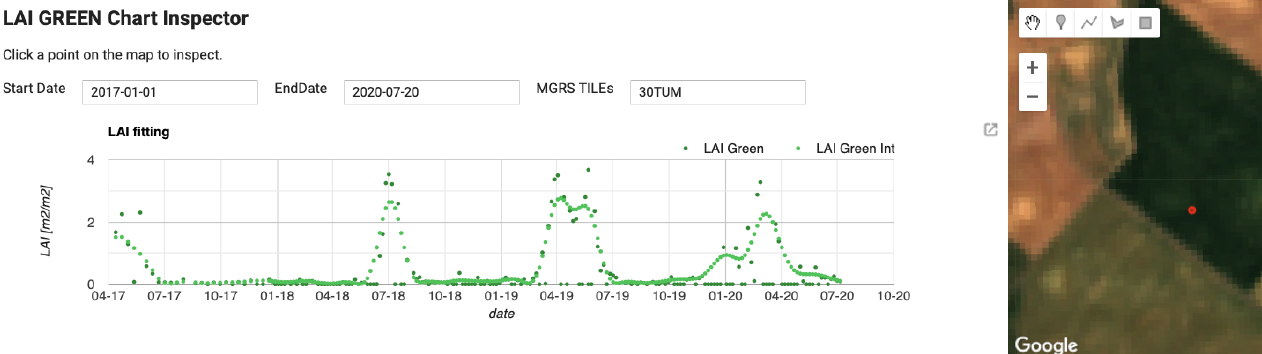
Figure 7. Original and gapfilled LAI G time series of a crop pixel with the area of study generated using GEE visualization APIs. The time span corresponds to the whole collection of S2 L2A imagery distributed by ESA available in